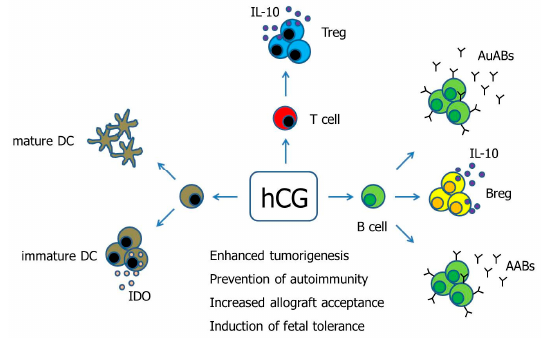
Figure 1. Hypothetical scenario proposing pathways of hCG-mediated immune modulation. Human Chorionic gonadotropin (hCG) has been suggested to differentially regulate DCs depending on the DC tissue-type. Moreover, hCG drives the conversion of conventional T cells into fully functional Treg cells.